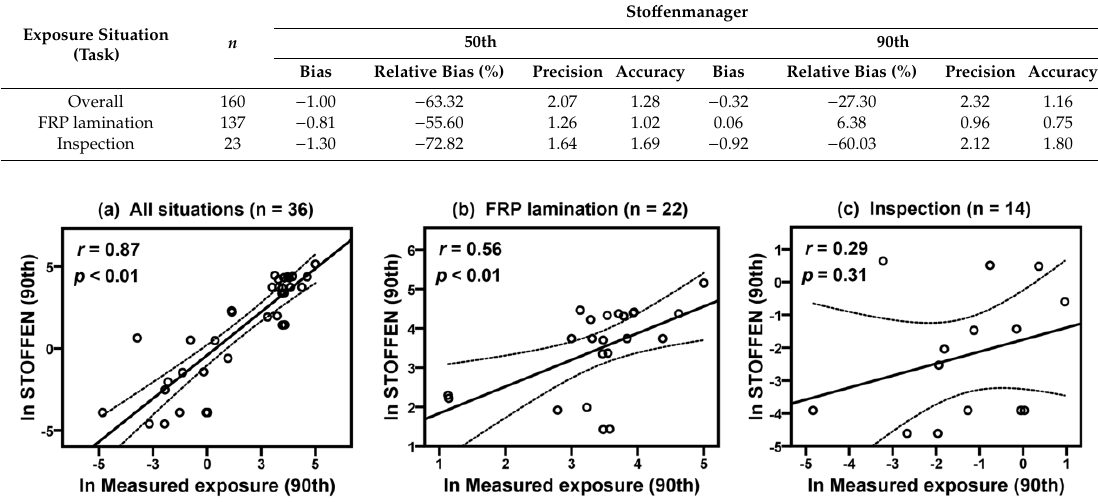
Figure 1. Scatterplots of the log-transformed model estimations (90th) of Stoffenmanager and exposure measurements (90th) for styrene collected on the FRP lamination and inspection tasks on situation level. The dashed lines indicate corresponding 95% confidence intervals (CIs).